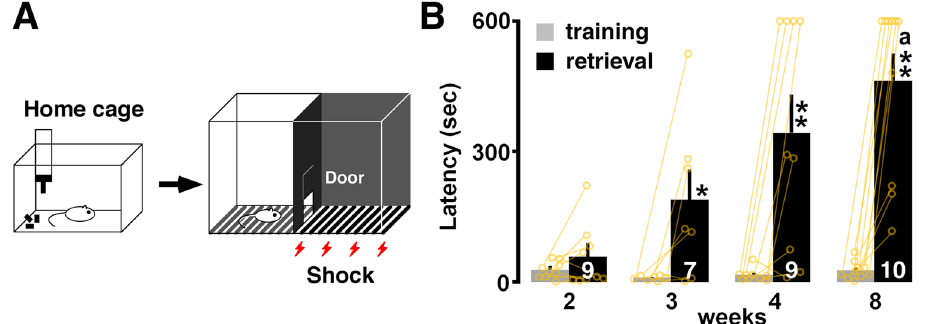
Figure 1. Inhibitory avoidance (IA) task and postnatal development of performance. ( A ) On the training day, we moved the rats from their home cage to the light box. ( B ) Thirty minutes after the training, a longer latency to enter the dark side of the box was observed at 3–8 weeks. The number of rats is shown at the bottom of each bar. Data are shown as individual points and are the mean ± SEM. * P < 0.05 vs. training. ** P < 0.01 vs. training. a P < 0.05 vs. 2